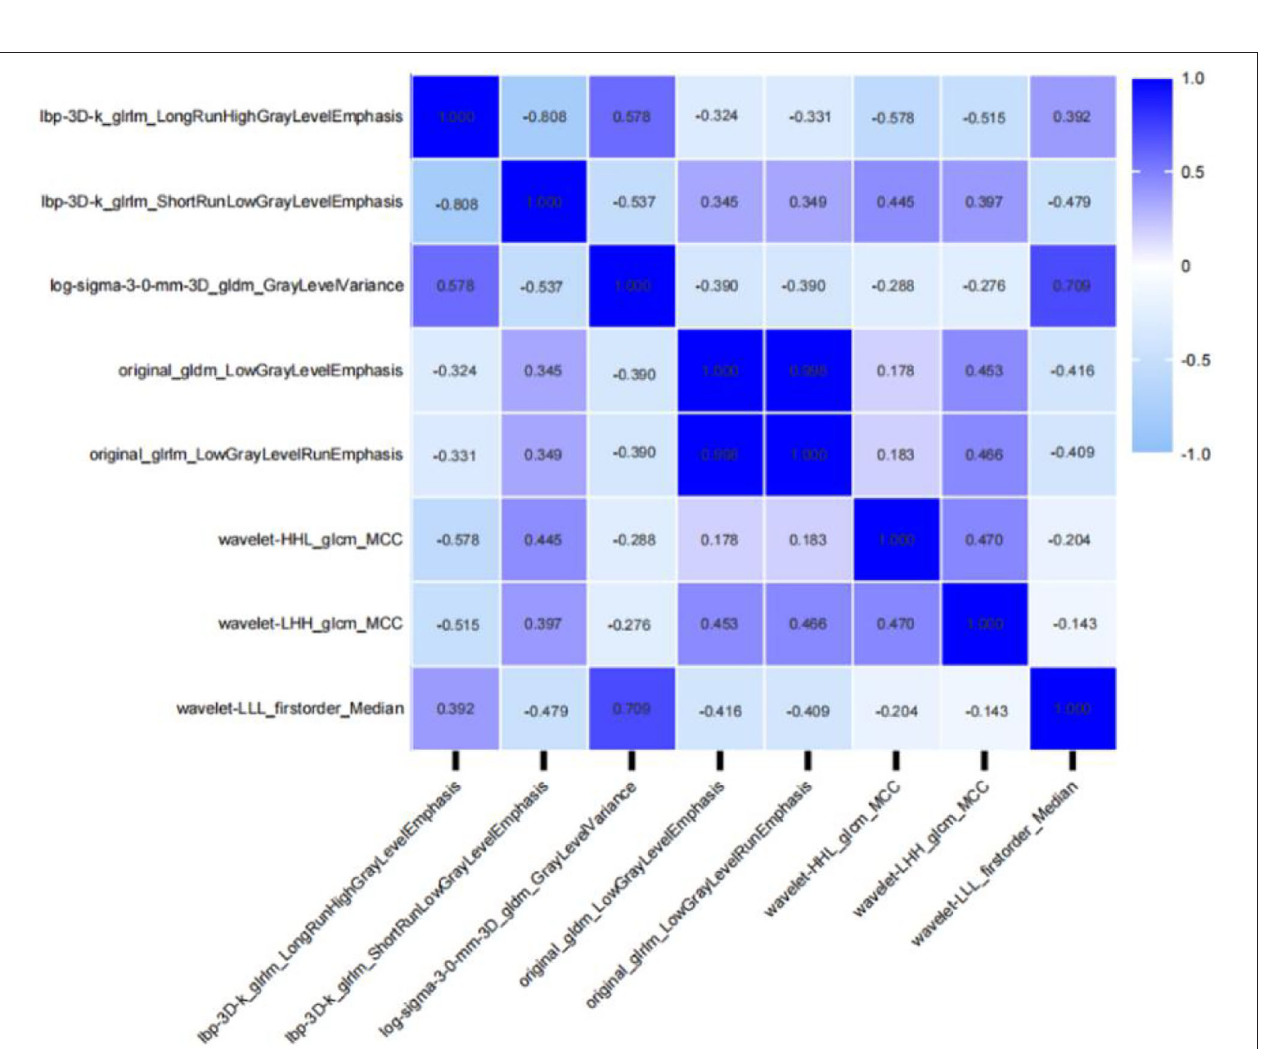
Frontiers in Surgery |